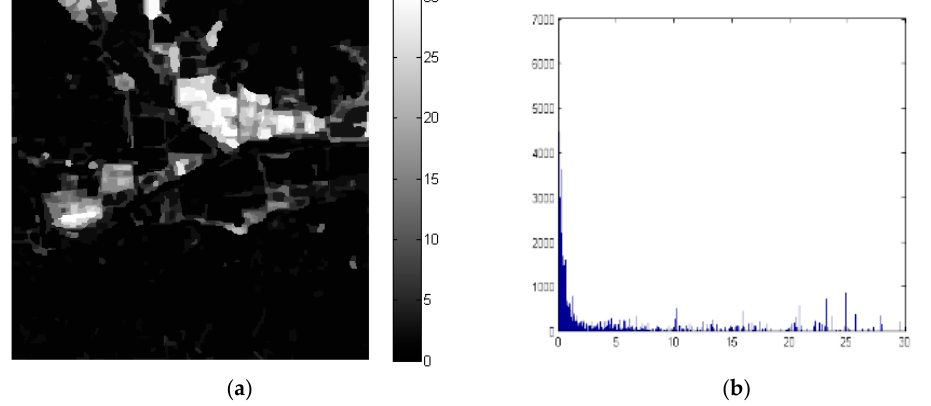
Figure 9. ( a ) The DI after GSRM; ( b ) Histogram of the DI after GSRM.